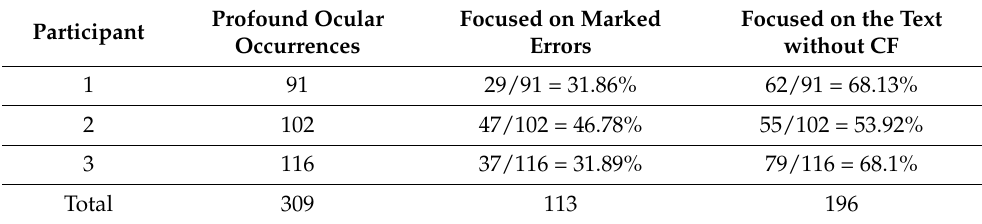
Table 10. Profound ocular activity focused on CF vs. the text without